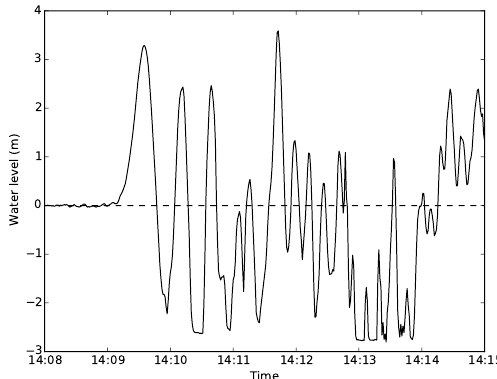
Figure 6. The tsunami wave height at the shore opposite of the glacier measured with a pressure